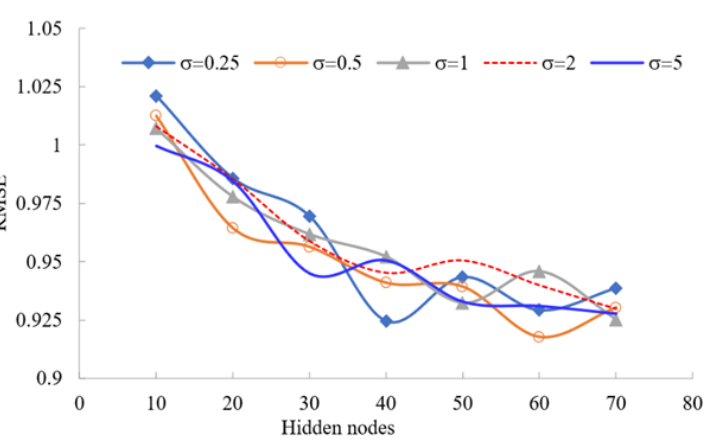
Figure 15. The RMSE for various hidden nodes of different RBFNN models; see abbreviations in